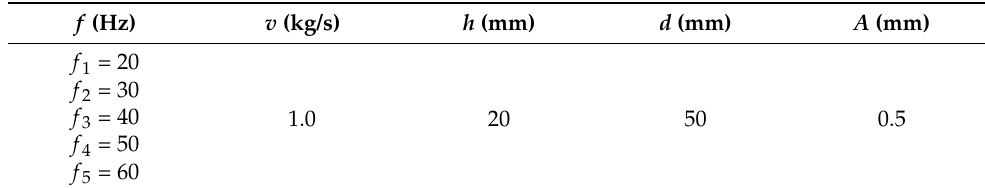
Table 8. Simulation parameters at different